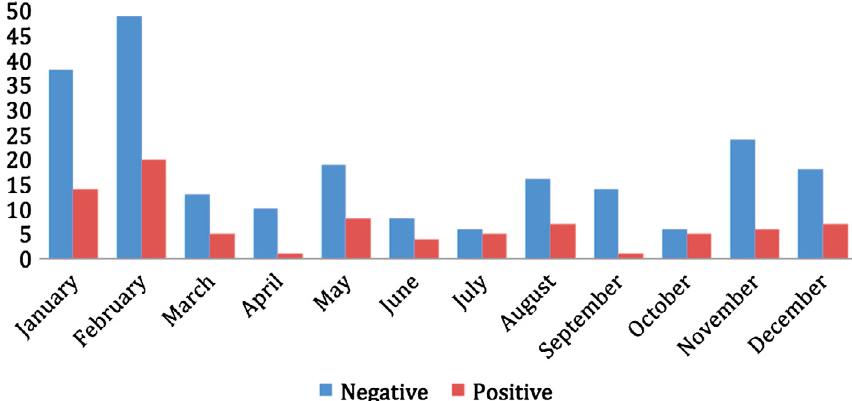
Figure 1. Distribution of heartworm results in investigated dogs according to